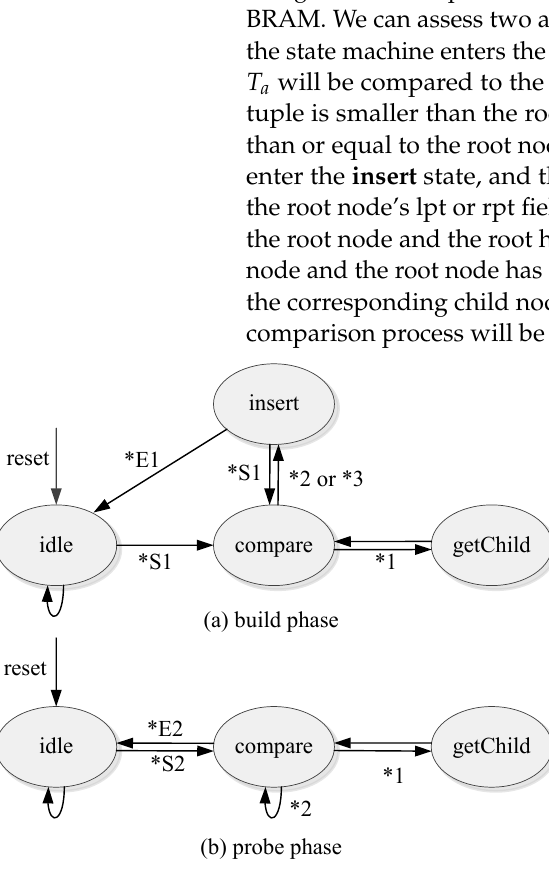
Figure 5. State diagram of the FSMs used in the build phase and probe